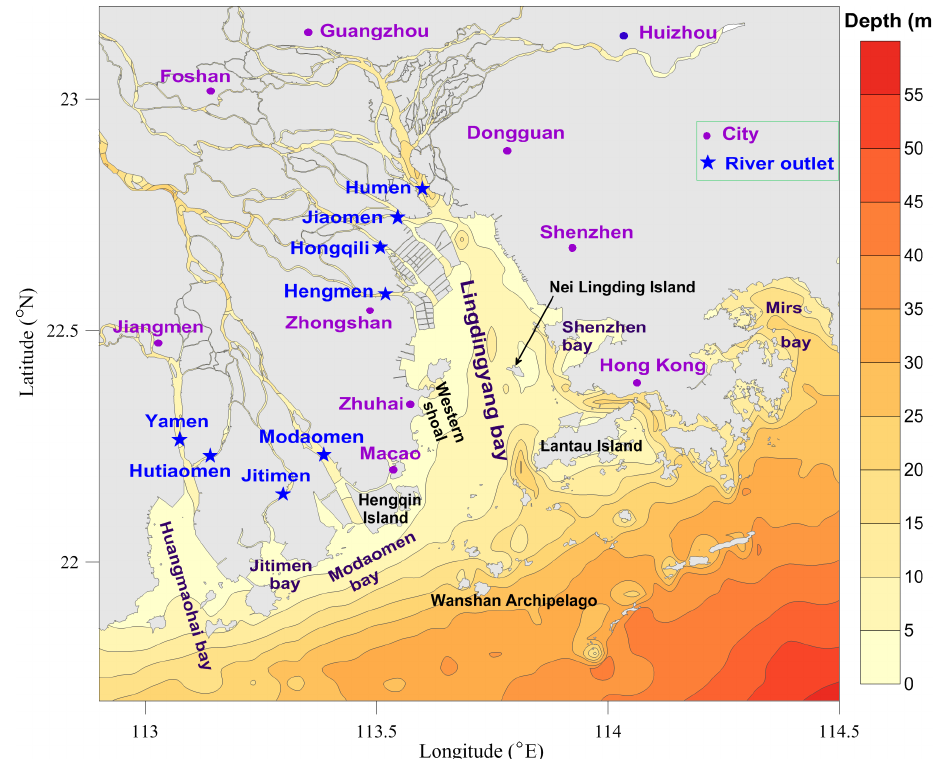
Figure 1. Map of the Pearl River estuary (PRE) and adjacent coastal waters. Note that the purple dots denote cities in the Guangdong–Hong Kong–Macao Greater Bay Area and the blue stars indicate the locations of eight outlets of the Pearl River freshwater discharged into the PRE; Humen, Jiaomen, Hongqili, and Hengmen are typically called the four eastern river outlets, while the others are called the four western river